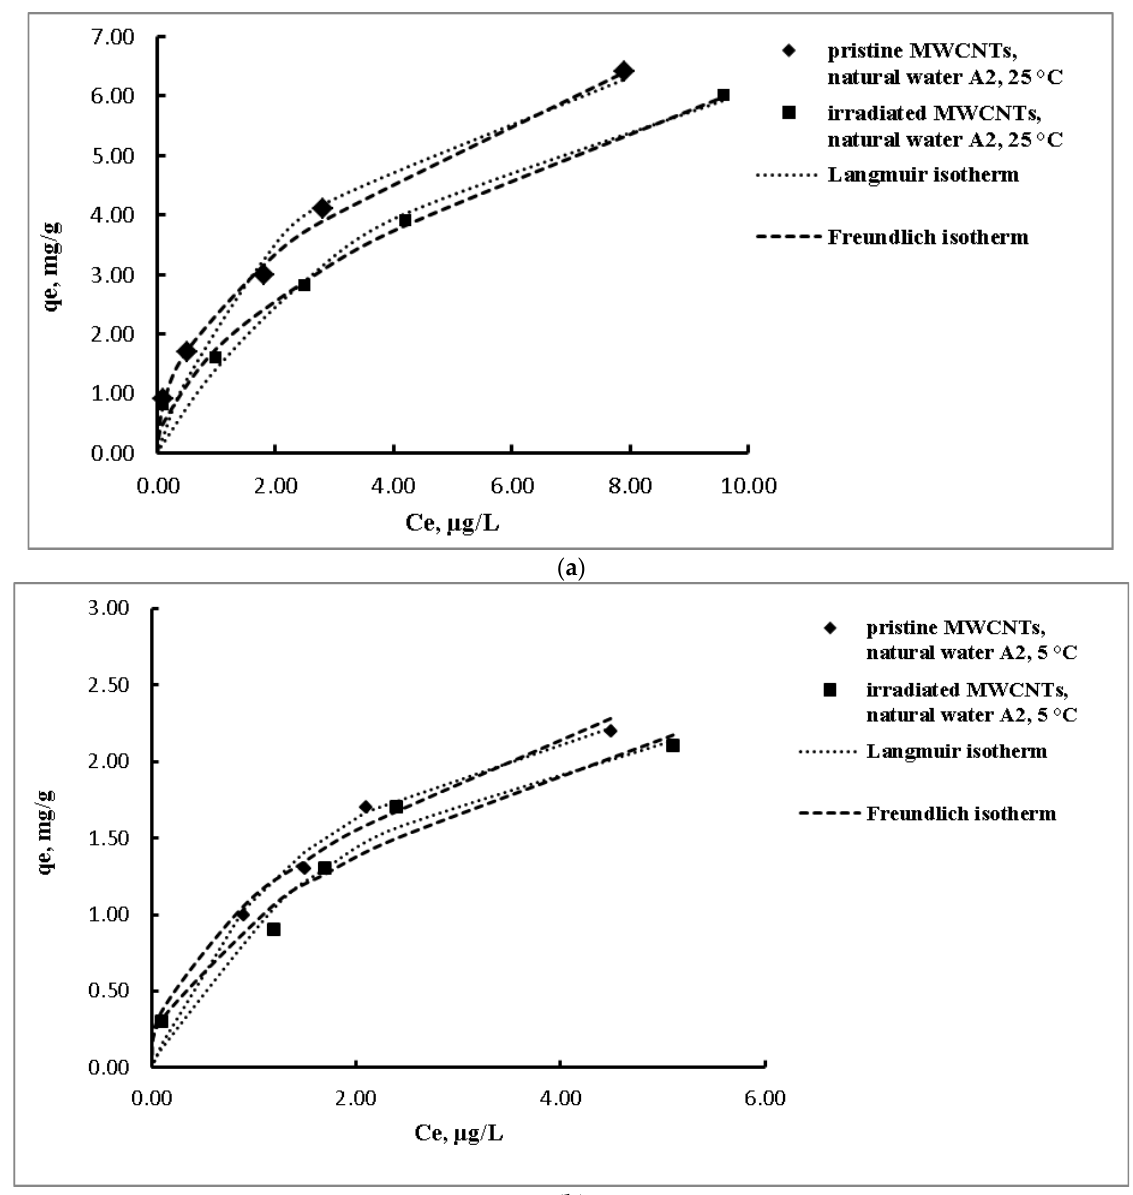
Figure 2. Langmuir and Freundlich non-linear adsorption isotherms in natural surface water A2 at